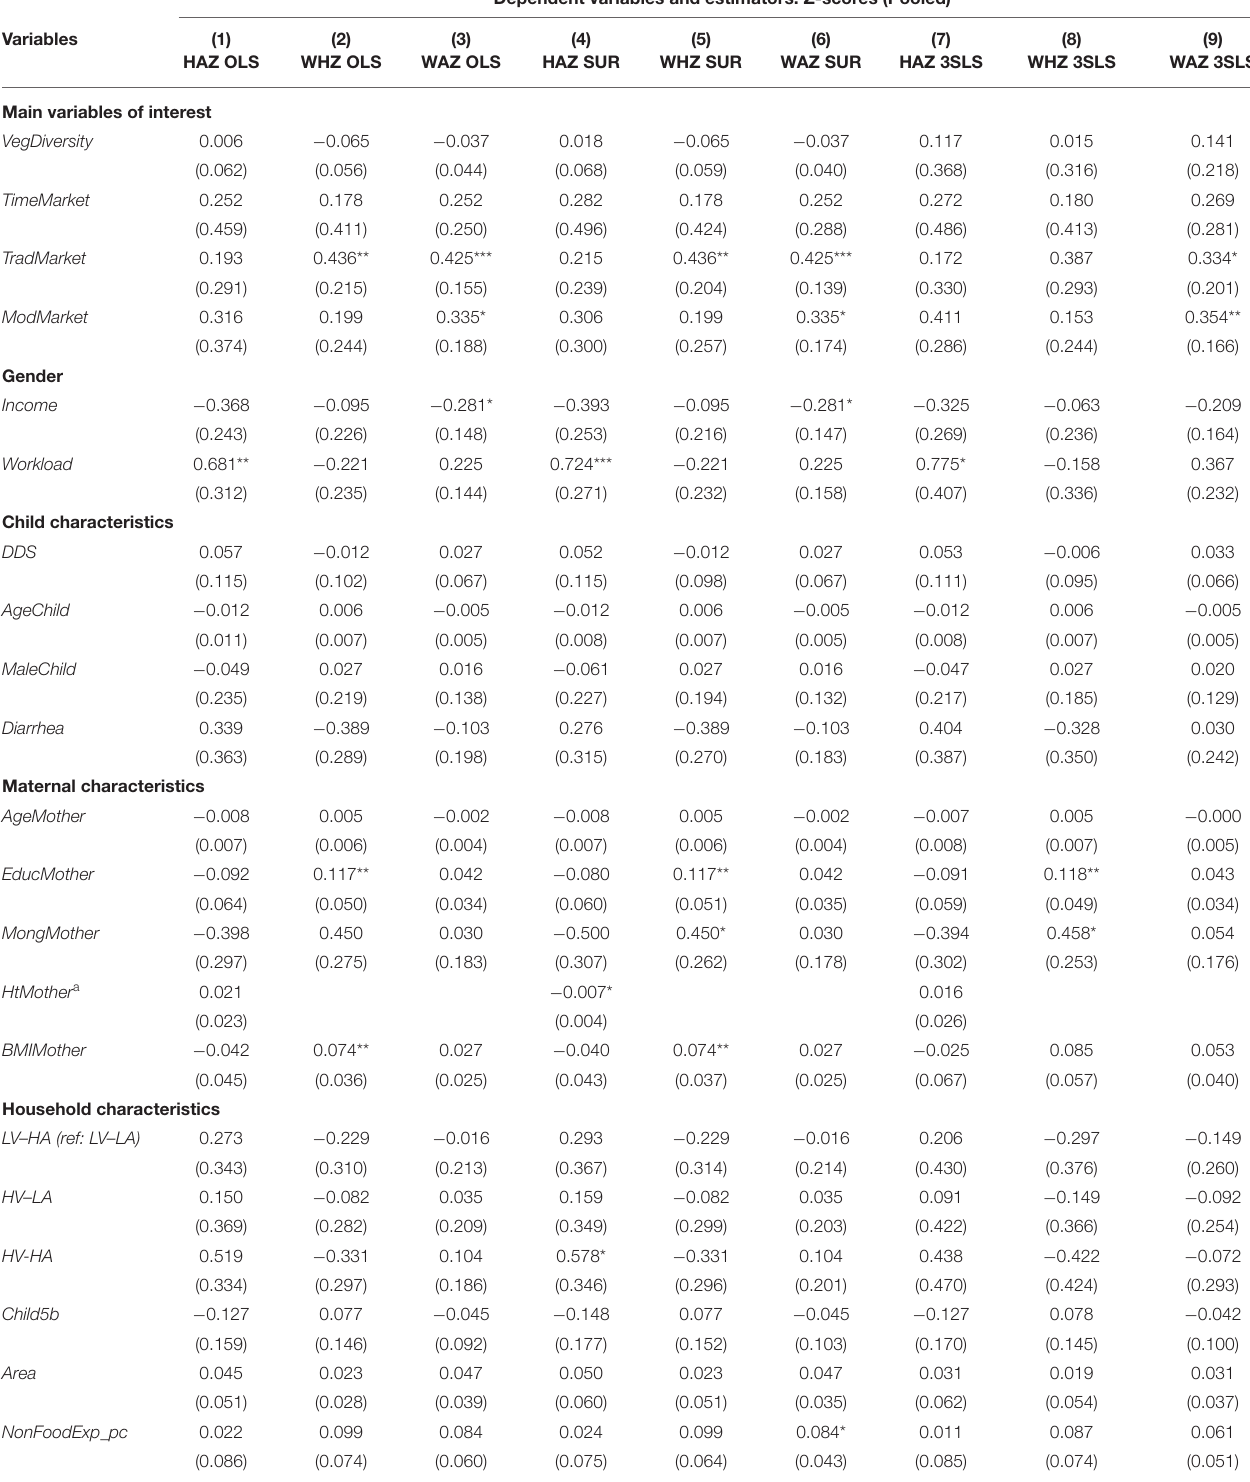
TABLE 2 | Impact of smallholder vegetable production on HAZ, WHZ, and WAZ of pooled sample. Dependent variables and estimators: Z-scores